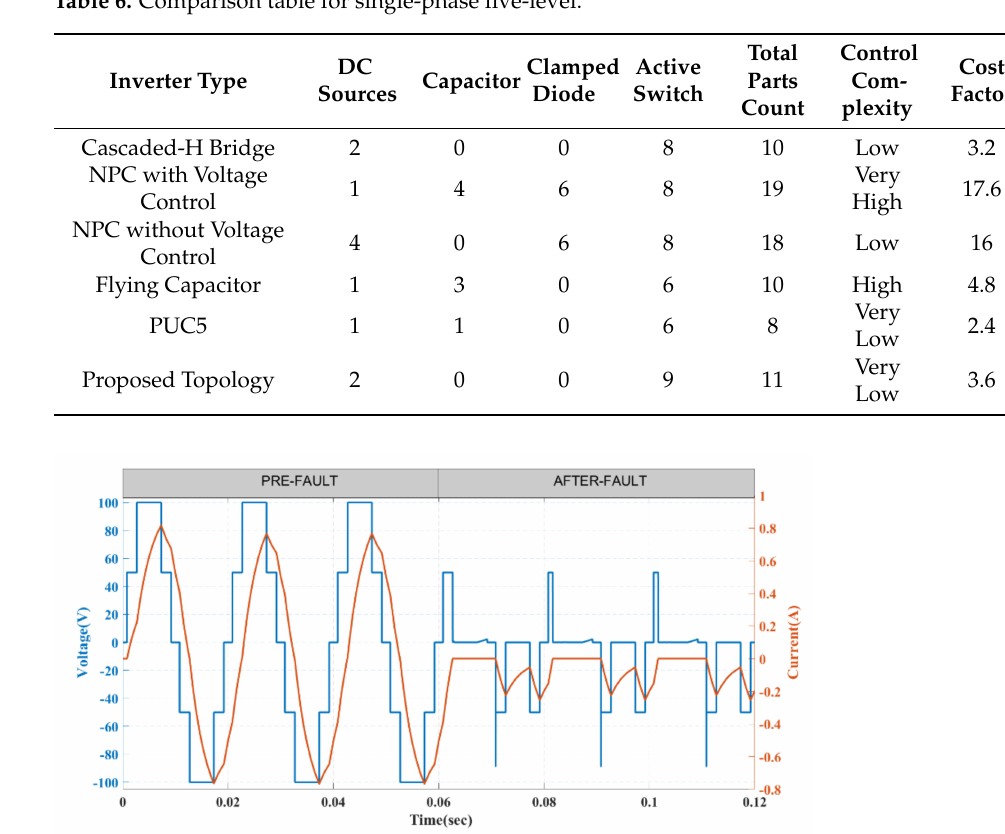
Figure 13. Pre-fault and post-fault output voltage and current waveform for